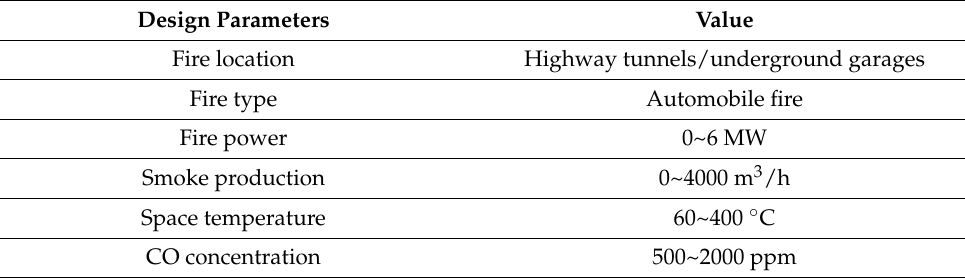
Table 1. The design parameters of the FSDS working fire